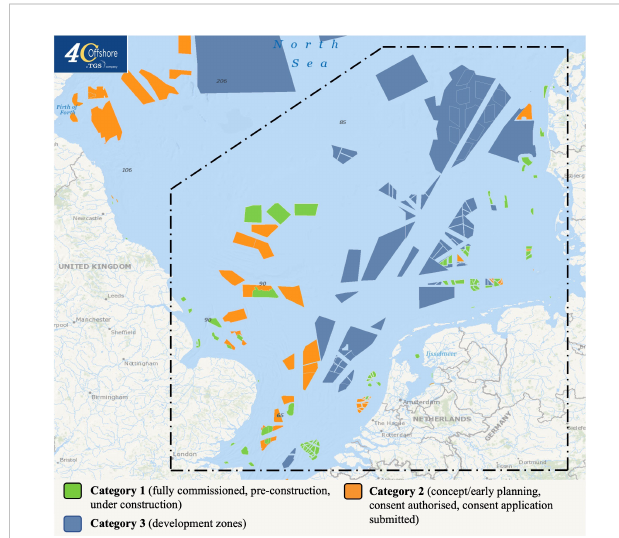
FIGURE 2 Study area in the SNS. OWFs are divided into three categories based on their construction and planning status as of 2022. Category I includes fully commissioned, pre-construction and under construction wind farms (green), category II includes consent application submitted, consent authorized and concept/early planning wind farms (orange) and category III includes development zones (blue) (edited map from 4C offshore (2022)). For our calculations, we focus on OWFs of category I and